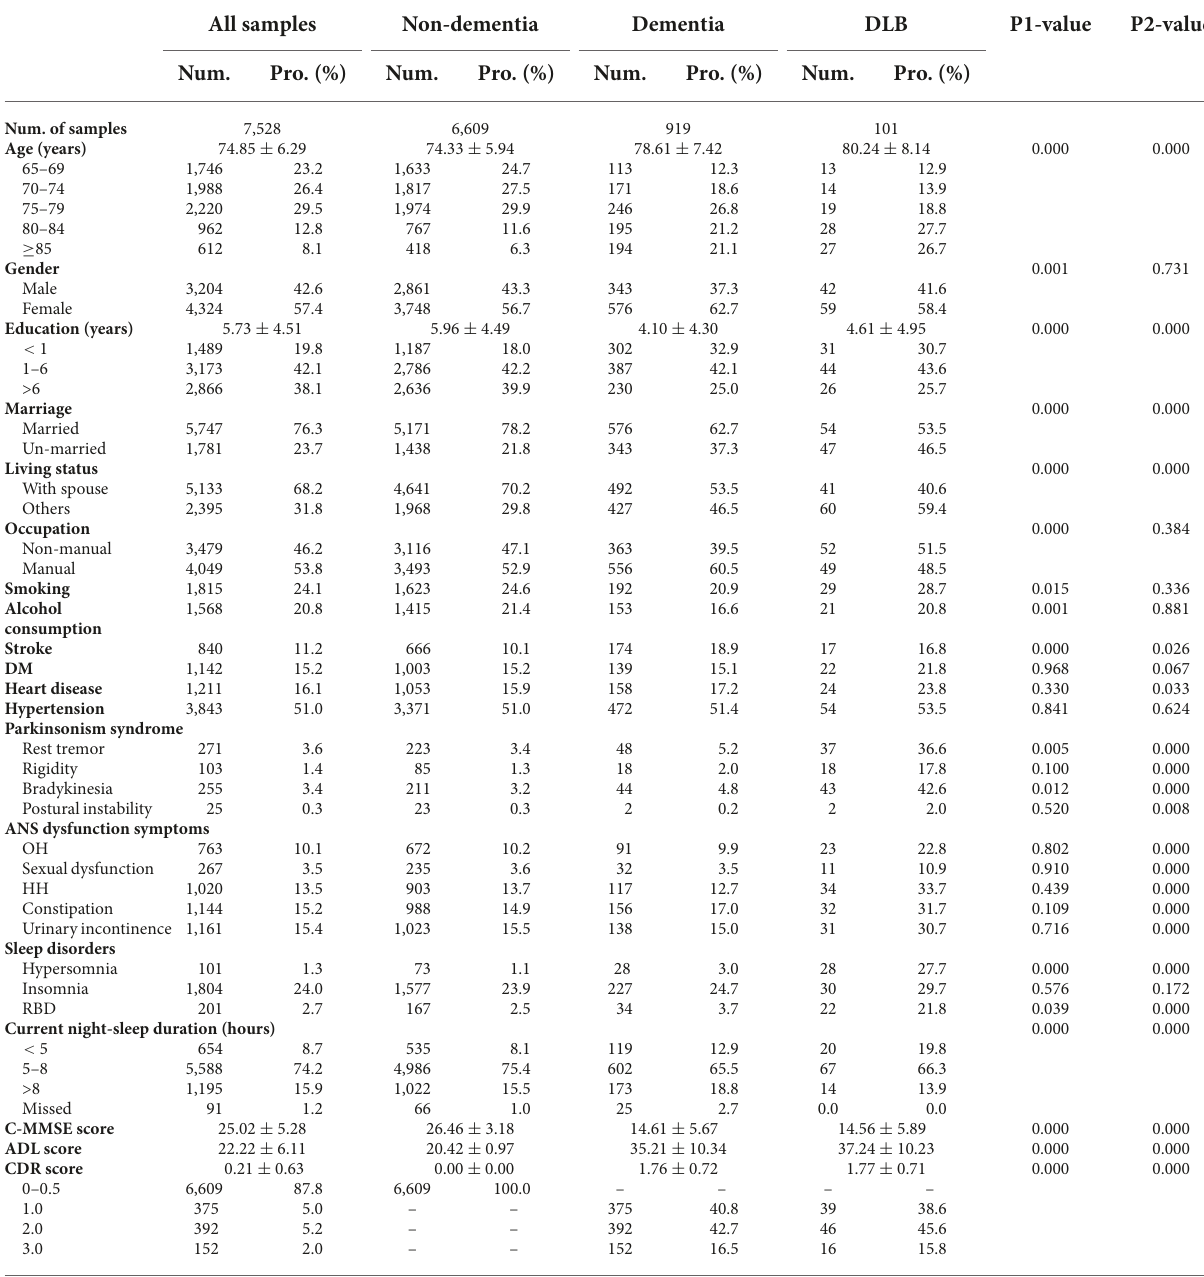
TABLE 1 Sample characteristics by cognitive performance. All samples Non-dementia Dementia DLB P1-value P2-value Num. Pro. (%) Num. Pro. (%) Num. Pro. (%) Num. Pro.